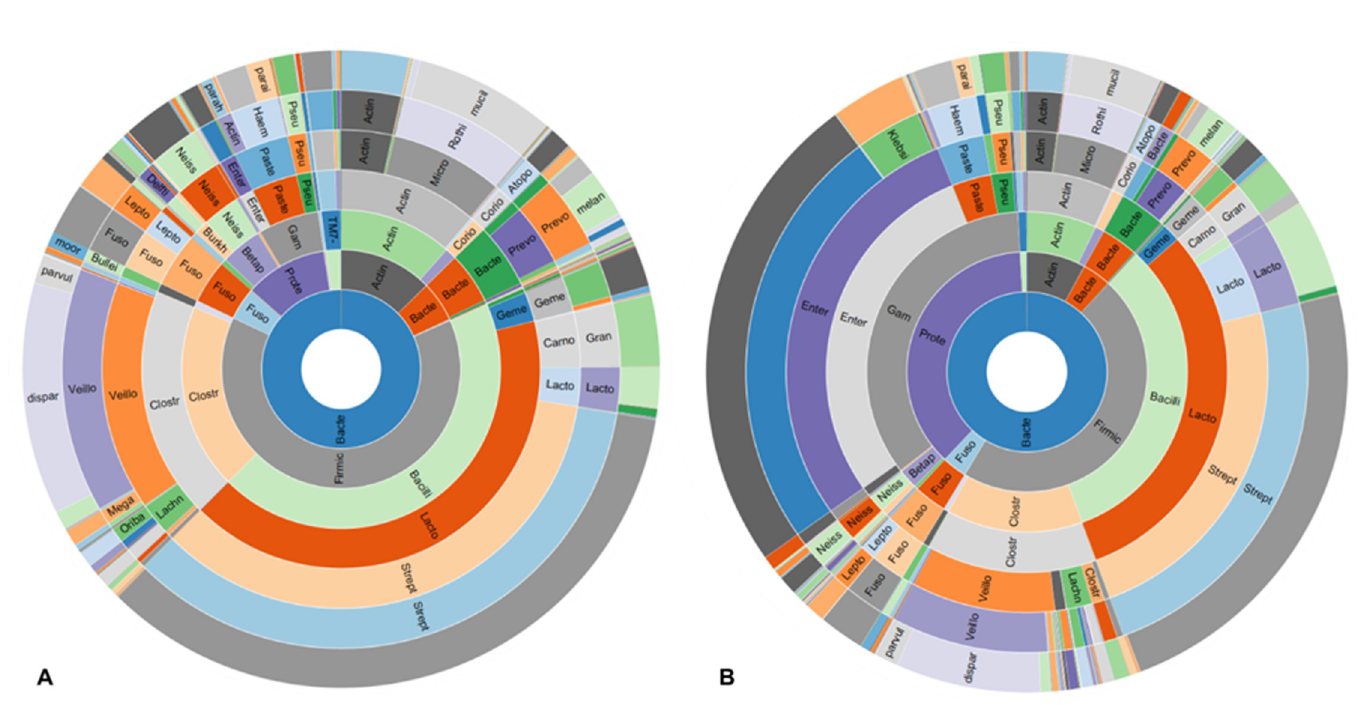
Fig 3. Sunburst representation of the duodenal microbiome in (A) non-SIBO (N = 98) and (B) SIBO (N = 42) subjects.